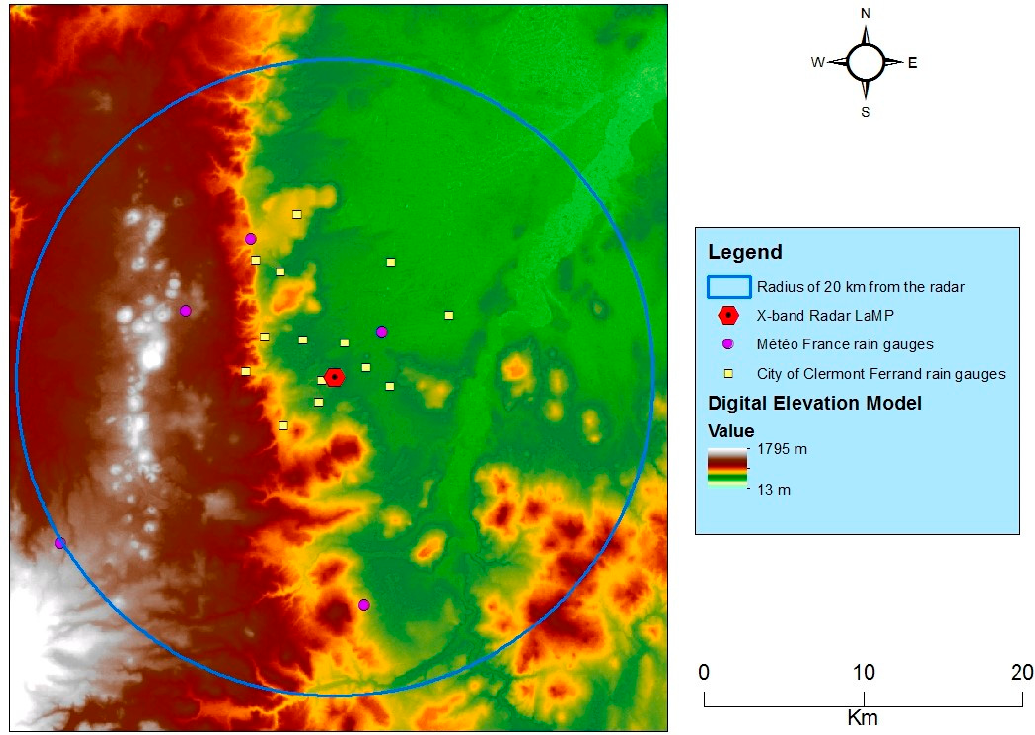
Figure 2. A digital elevation map of the study area with the location of the Clermont Auvergne and Météo-France rain gauges.